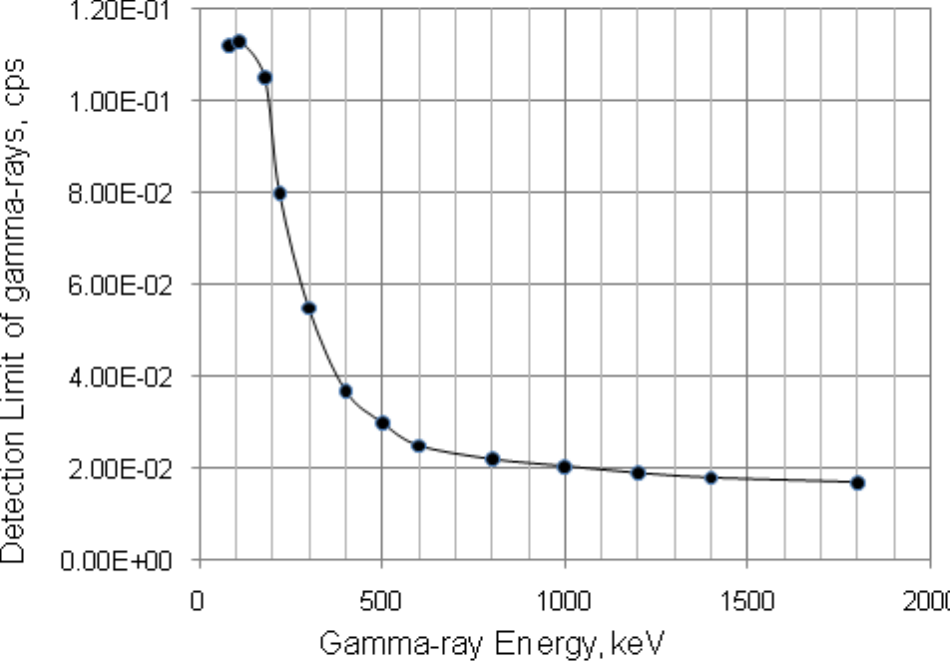
Figure 13. Detection limits of photo peaks, L (not corrected with detector counting D efficiency and gamma ray yield) evaluated from a background spectrum of blank sample measured for 36,000 s on HP Ge detector coupled ORTEC gamma-ray